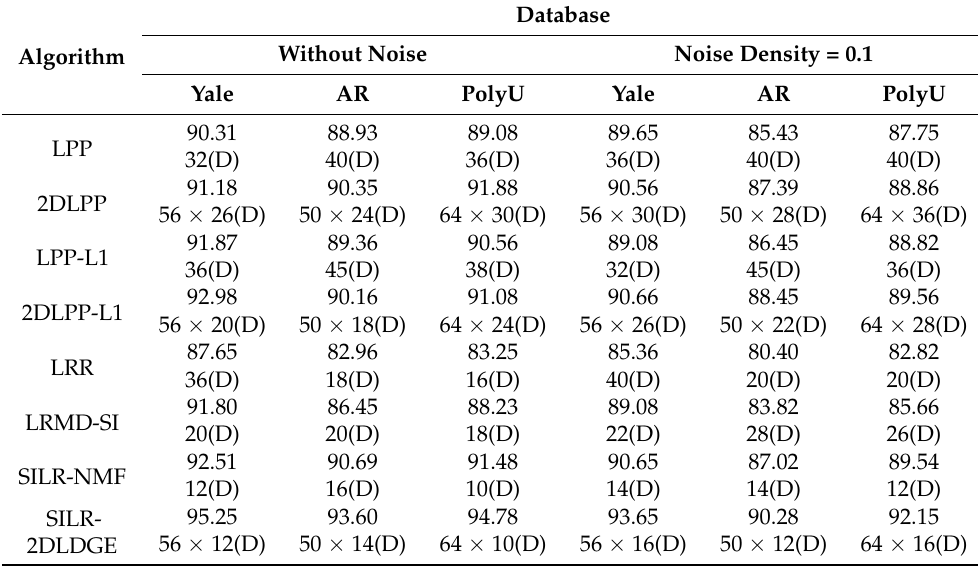
Table 3. The best average recognition rates (%) of different algorithms and corresponding dimensions (D) on the Yale, AR, and PolyU databases and the corresponding dimensions.